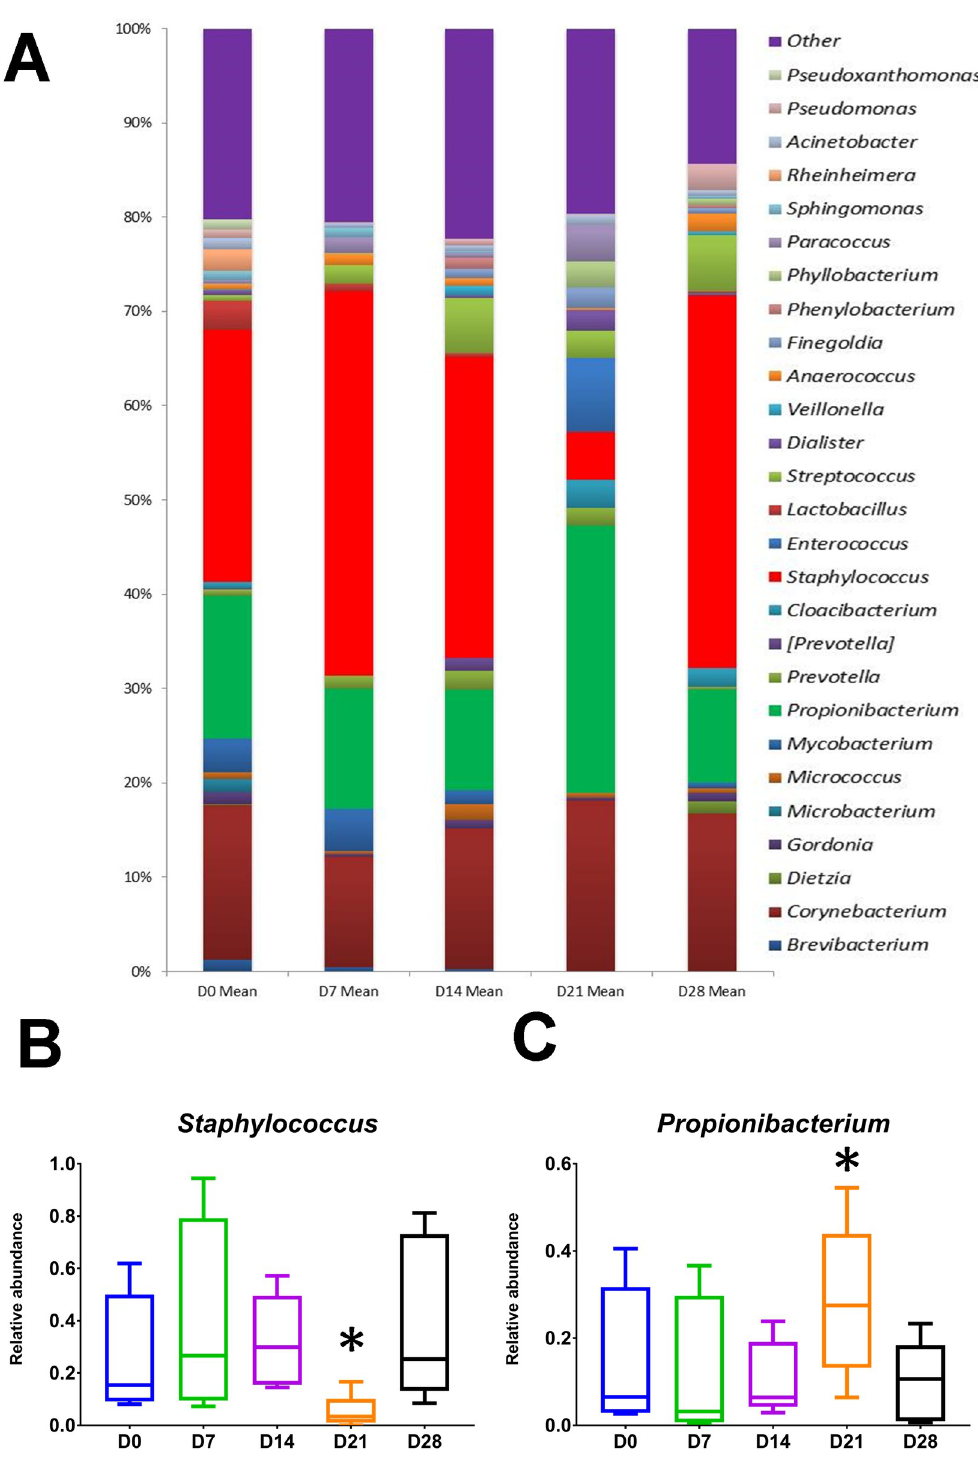
Fig 5. Wound microbiome. (A) Mean relative abundances of bacterial taxa between time points. Relative abundance is shown on the Y-axis. Taxa are filtered to those with a mean abundance greater than 1%. (B and C) Boxplots showing the relative abundances of Staphylococcus and Propionibacterium across time points. � denotes P < 0.05, as determined by Wilcoxon’s signed ranks test.